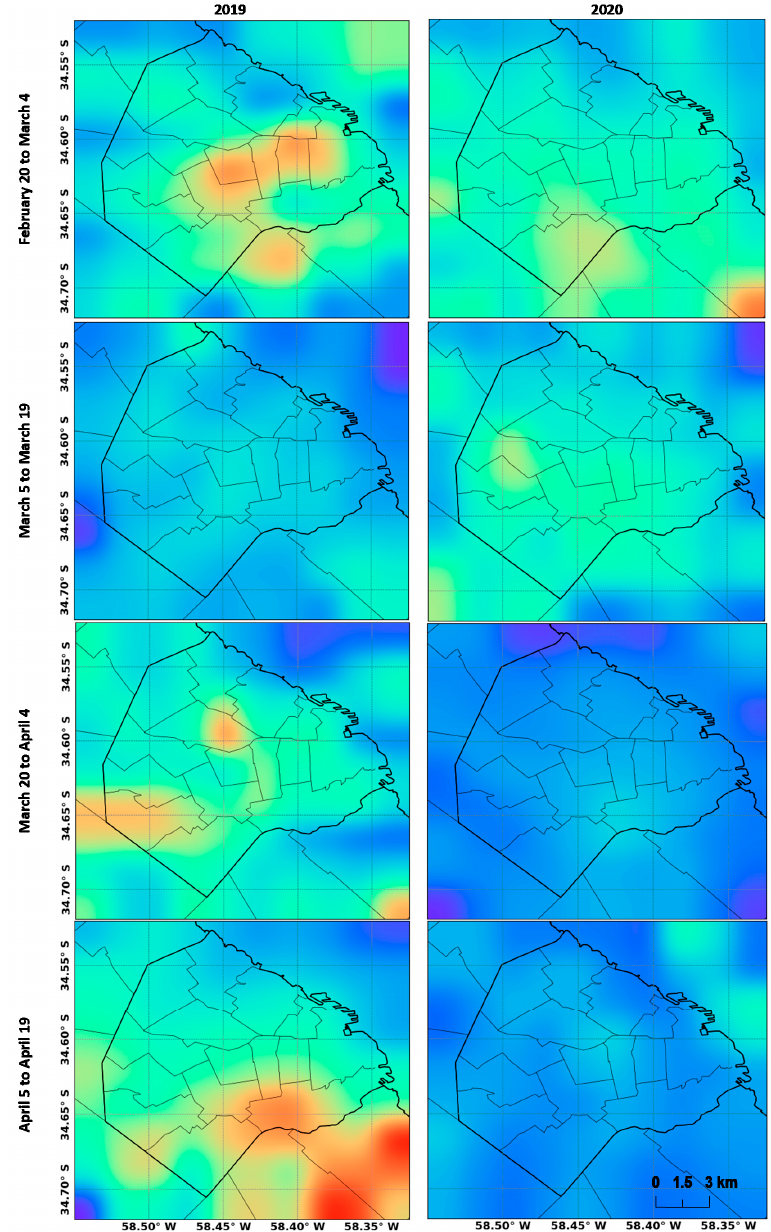
Figure 8. Mean levels of tropospheric NO 2 (moles / m 2 ) measured by the S5p / TROPOMI-ESA in 2019 and 2020, both in the weeks corresponding to before, during, and in relaxation of the lockdown in